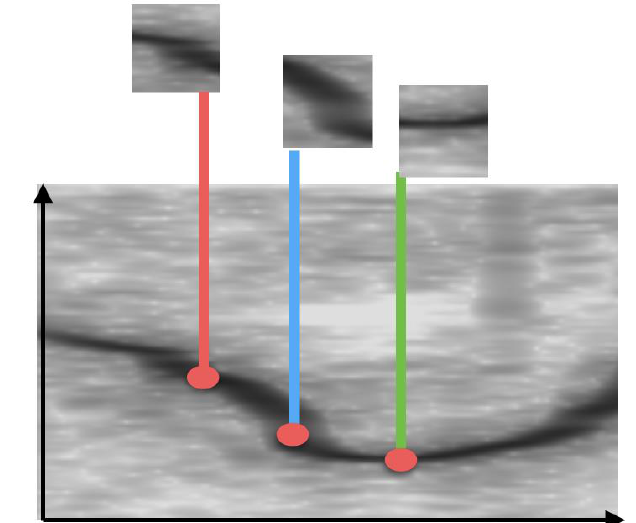
Figure 8. Three patches extracted around a dolphin signal. Two are around different down sweeps and one around a plateau.